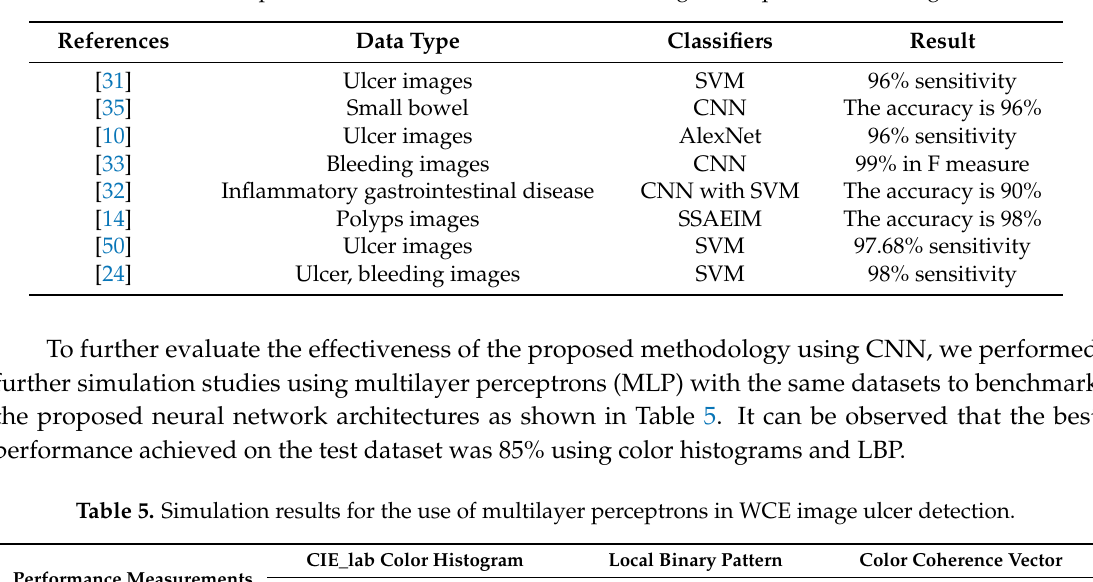
Table 4. Comparison of state-of-the-art machine learning techniques in WCE images.